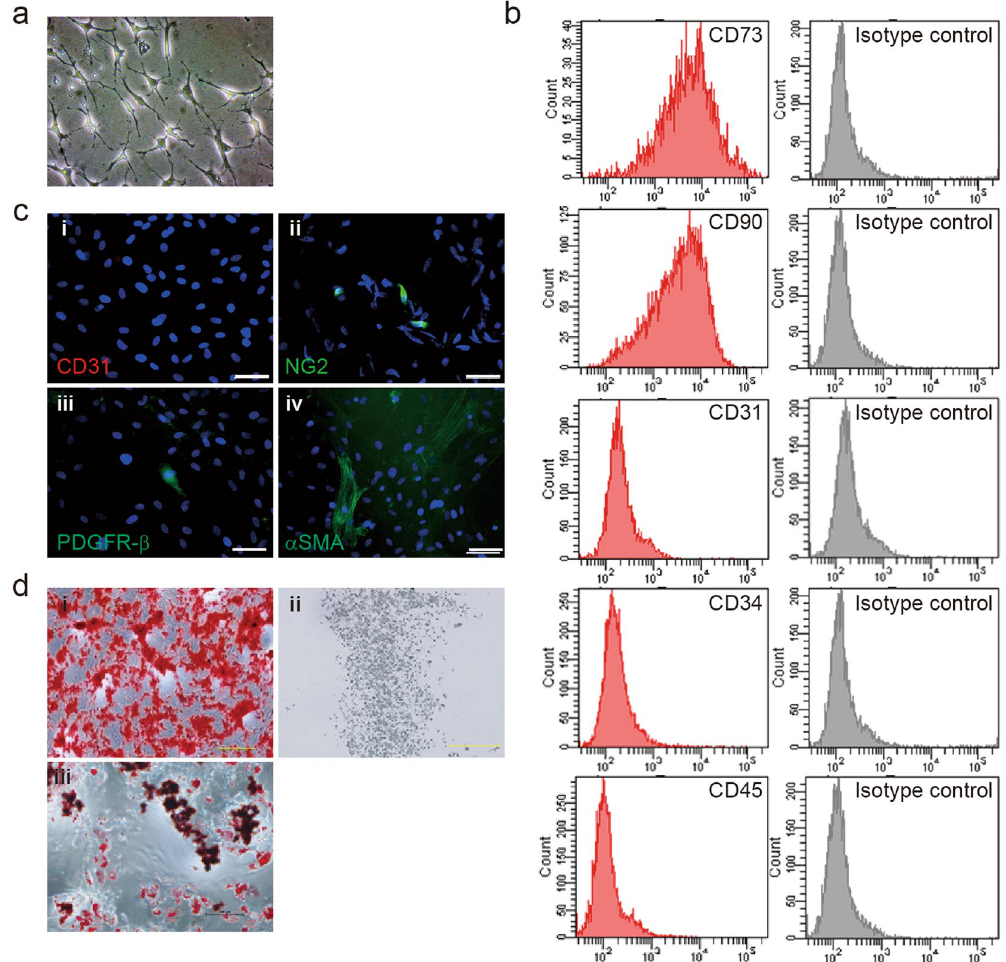
Figure 3. ASCs comprise mostly mesenchymal stem/stromal cells (MSCs) with pericytes and smooth muscle cells. ( a ) Phase-contrast image of ASCs 3 days after initial plating (passage 0). ( b ) FACS analysis of ASCs measuring the expression of MSC markers 5 days after initial plating. Passage-0 ASCs expressed the MSC markers CD73 and CD90 and lacked endothelial CD31 and hematopoietic CD34 and CD45 cell markers. ( c ) Immunofluorescence analysis showed that ASCs lacked the EC marker CD31 (i, red) and expressed the pericyte markers chondroitin sulfate proteoglycan 4 (NG2; ii, green), platelet-derived growth factor receptor beta (PDGFR- β ; iii, green) and smooth muscle actin (SMA; iv, green). Scale bars: 50 μ m (i–iv). ( d ) Multi-lineage potential of passage-0 ASCs in vitro . ASCs were analyzed for osteogenic (i, Alizarin Red S), chondrogenic (ii, Alcian Blue), and adipogenic (iii, Oil Red O) differentiation